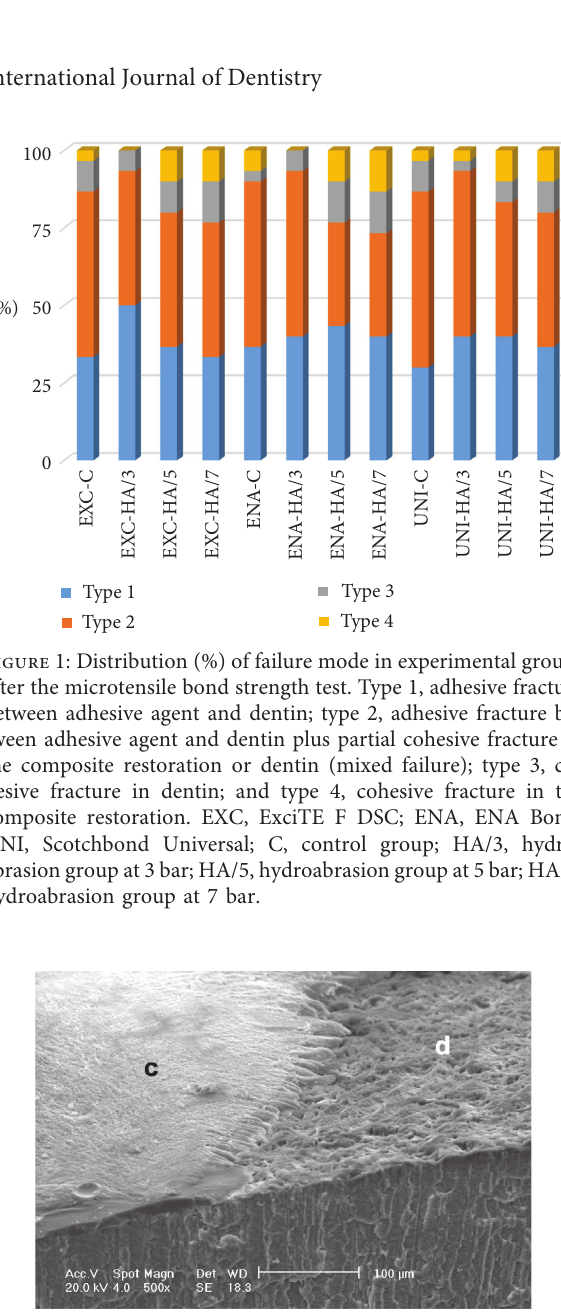
Figure 2: Scanning electron microscope (SEM) image of a type 2 failure (adhesive fracture between adhesive agent and dentin plus partial cohesive fracture in the composite restoration) (PB-A). c, composite; d, dentin. Magnification ×